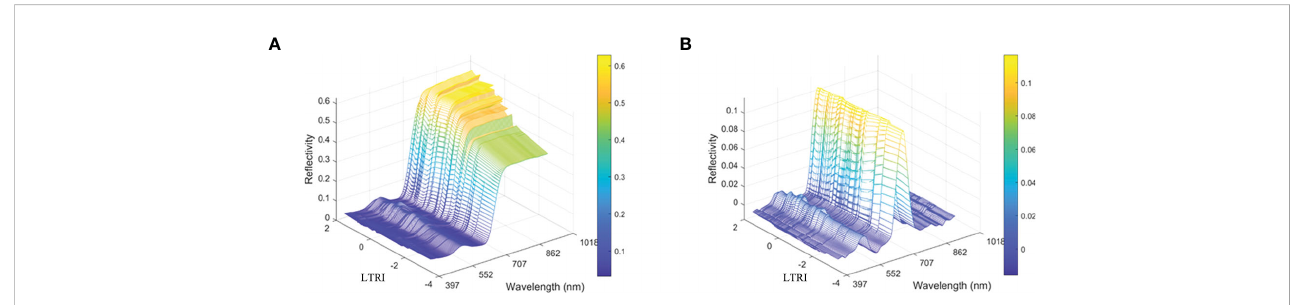
FIGURE 4 Image comparison of unprocessed spectral data and preprocessed spectral data. (A) Represent the original spectrum (B) Represent pretreatment